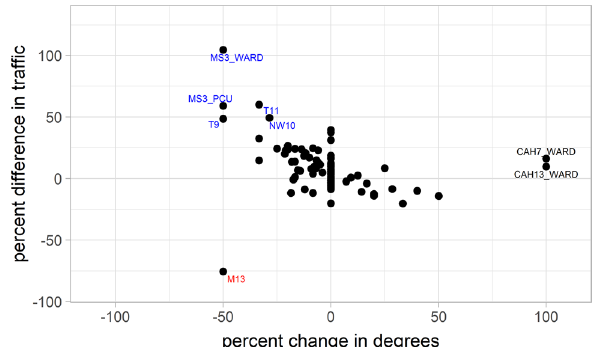
Figure 5. Change in node properties before and during the pandemic. The plot shows change in traffic through a node versus change in degree which represents connectivity to other hospitals or care locations. Two areas (CAH13_WARD and CAH7_WARD) significantly increased both their patient throughput and their connectivity whereas the M13 community reduced their patient supply to the